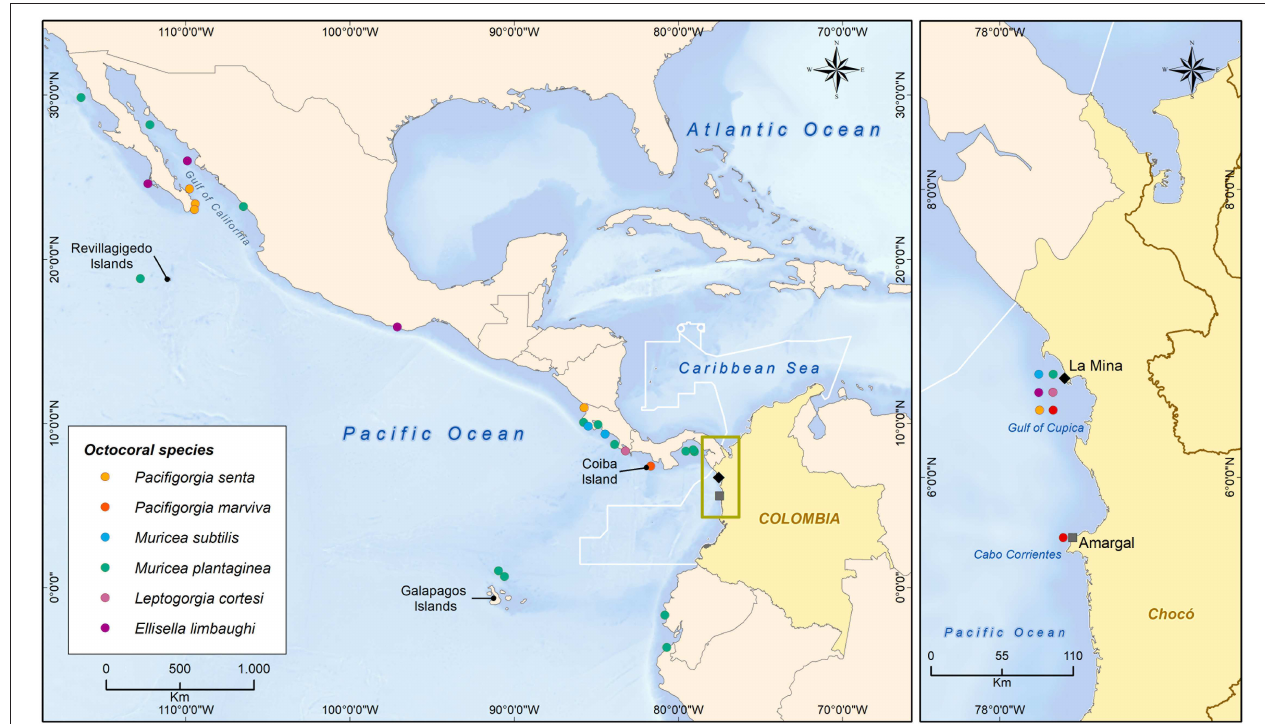
FIGURE 1 | Distribution map of the new octocoral records found in the Colombian Pacific, with species distribution along the ETP. The coordinates for species distribution in other countries were obtained from publications in the references list. Sample sites: (cid:7) La Mina, (cid:4)